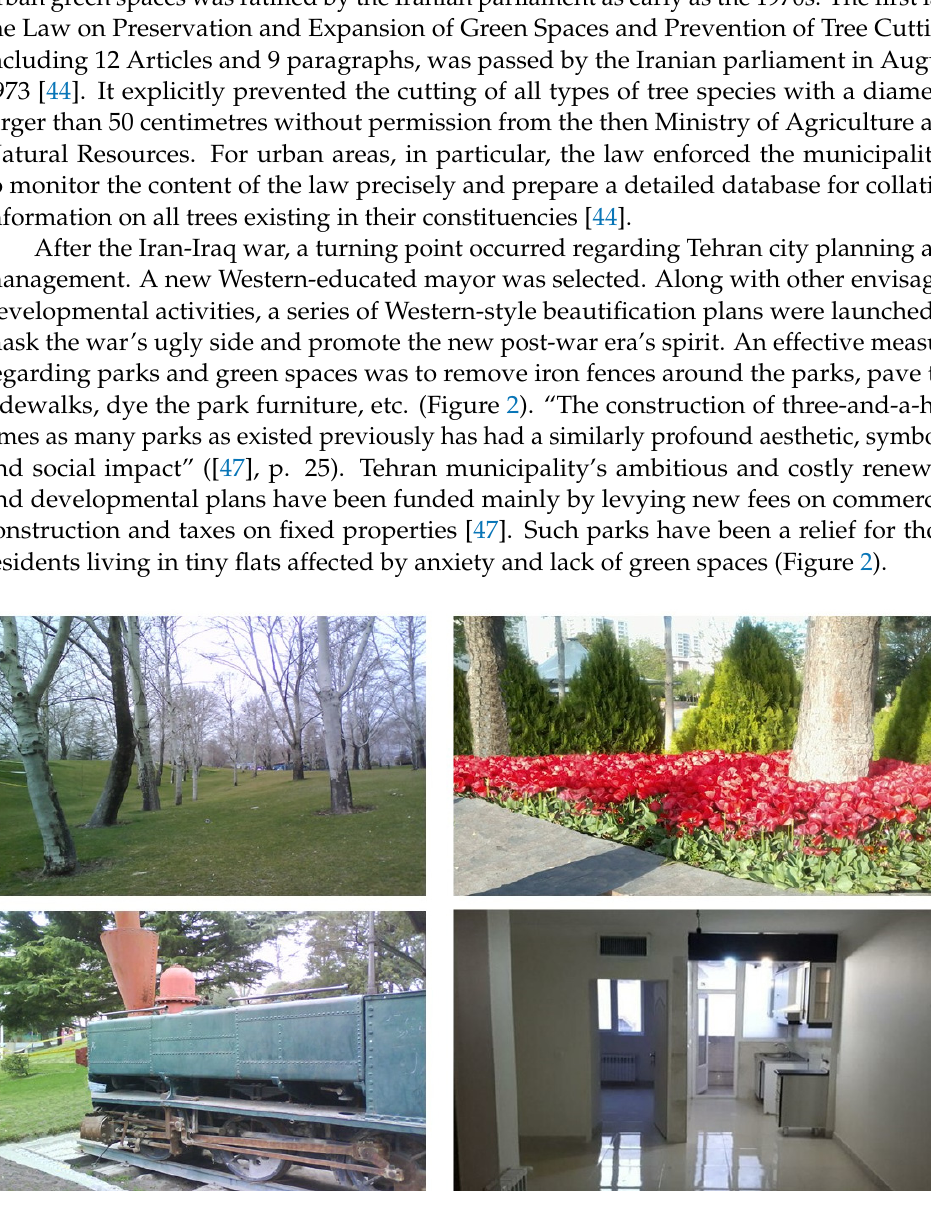
Figure 2. Modern Tehran urban life: a view of two different parks in the city north ( top-left ) and in the city centre surrounded by high-rise buildings ( top-right ); the symbolic first railway wagon used as a way of transport between Tehran and Ray city about one hundred years ago, located in one of Tehran’s parks ( bottom-left ); inside of a typical small apartment in the city centre: Sources ( bottom-right ):